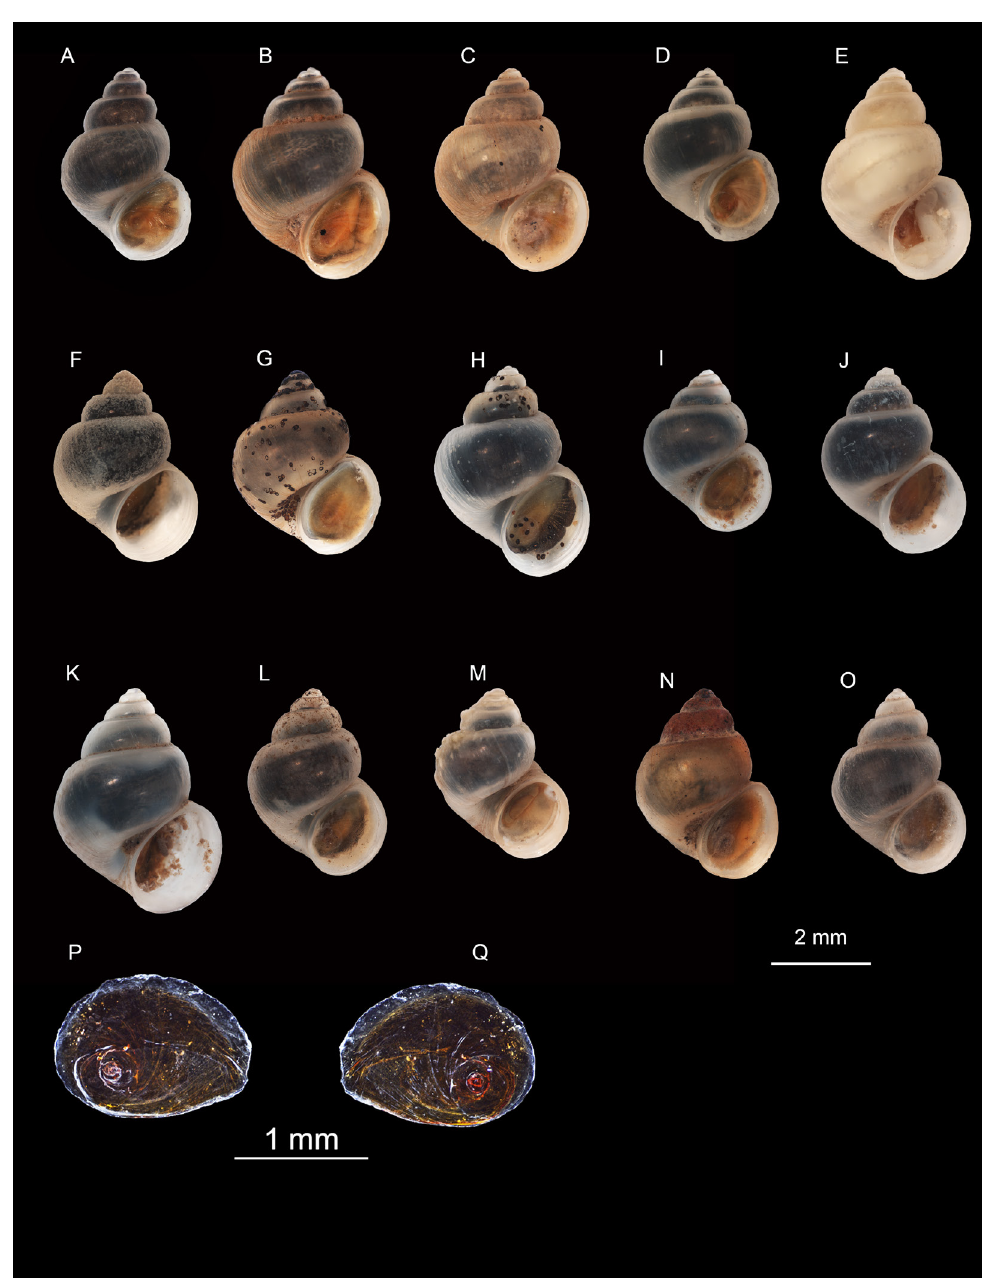
Fig. 4. Intraspecific variation of the shell shape and colour of Mercuria similis (Draparnaud,